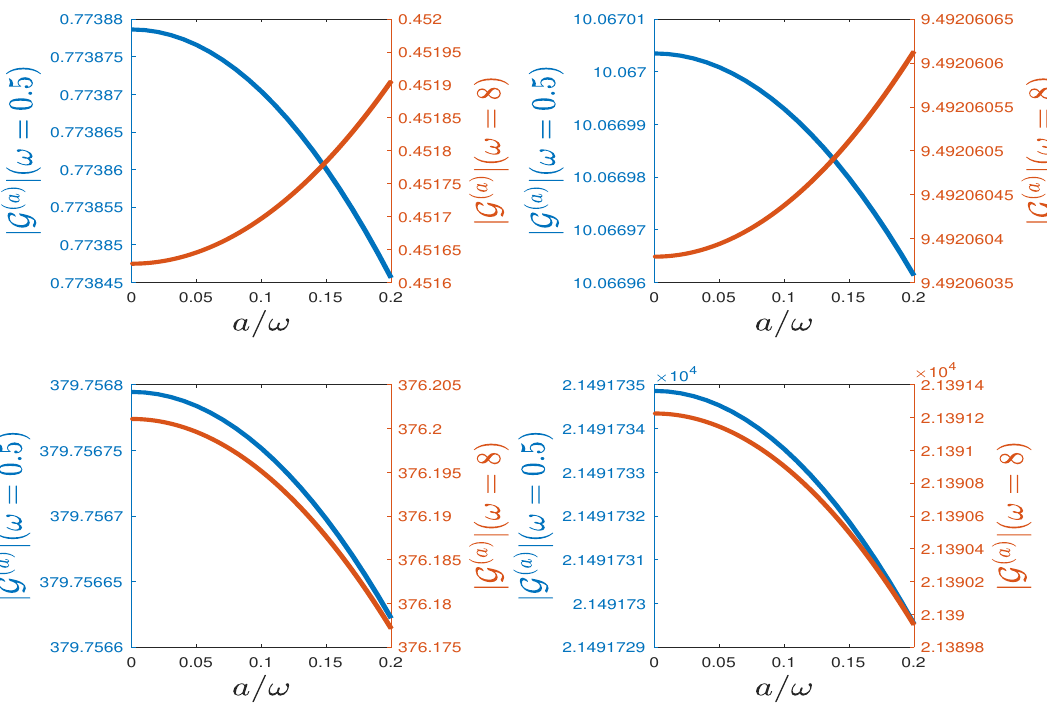
Figure 14 . Anti-Unruh effect in different spacetime dimensions. The four subfigures stand for D = 3 , D = 4 , D = 5 , and D = 6 , respectively, from left to right and top to bottom. Blue and red lines stand for ω = 0 . 5 and ω = 8 , respectively, with other parameters taking m = 1 , σ = 0 . 8